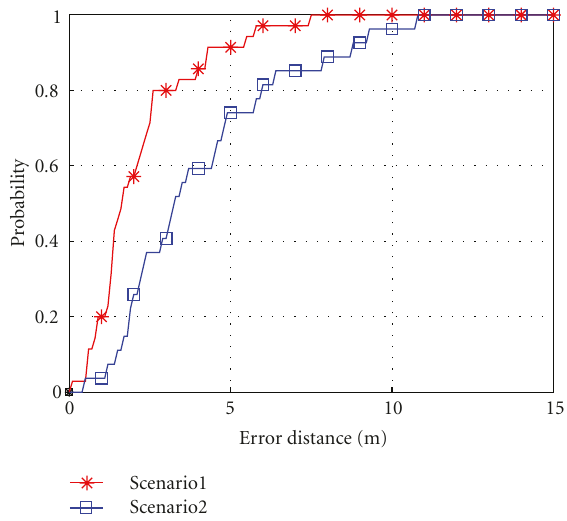
Figure 15: Cumulative distribution function results for point- based localization accuracies in Scenario 1 (23 anchor nodes) and Scenario 2 (12 anchor nodes).